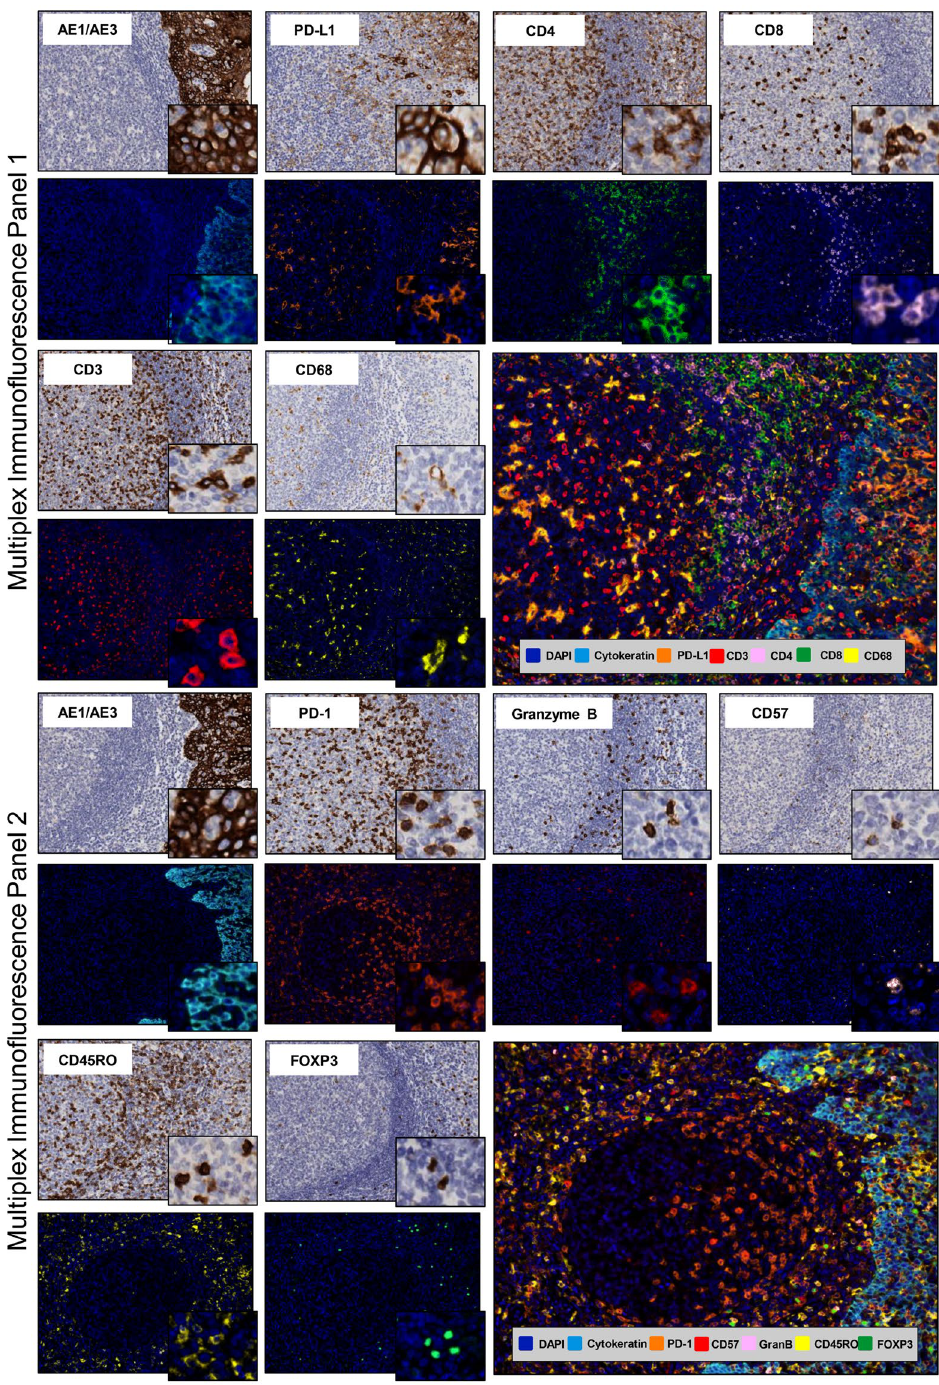
Figure 3. Microphotographs of representative examples of individual IHC and multiplex IF markers in tonsil tissue. Immune panels 1 and 2. × 200 magnification and high-power magnification of the positive